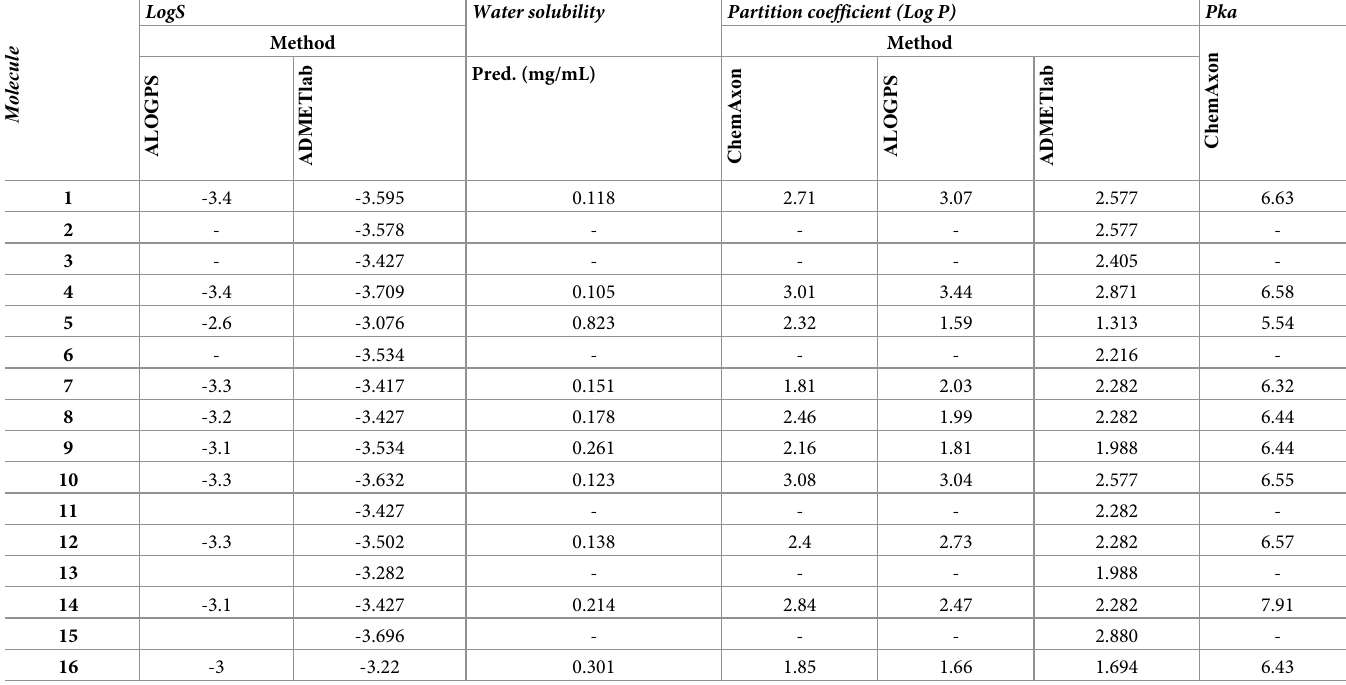
Table 2. Comparison of solubility, partition coefficient, water solubility, and P Ka of flavonoids predicted using different methods.